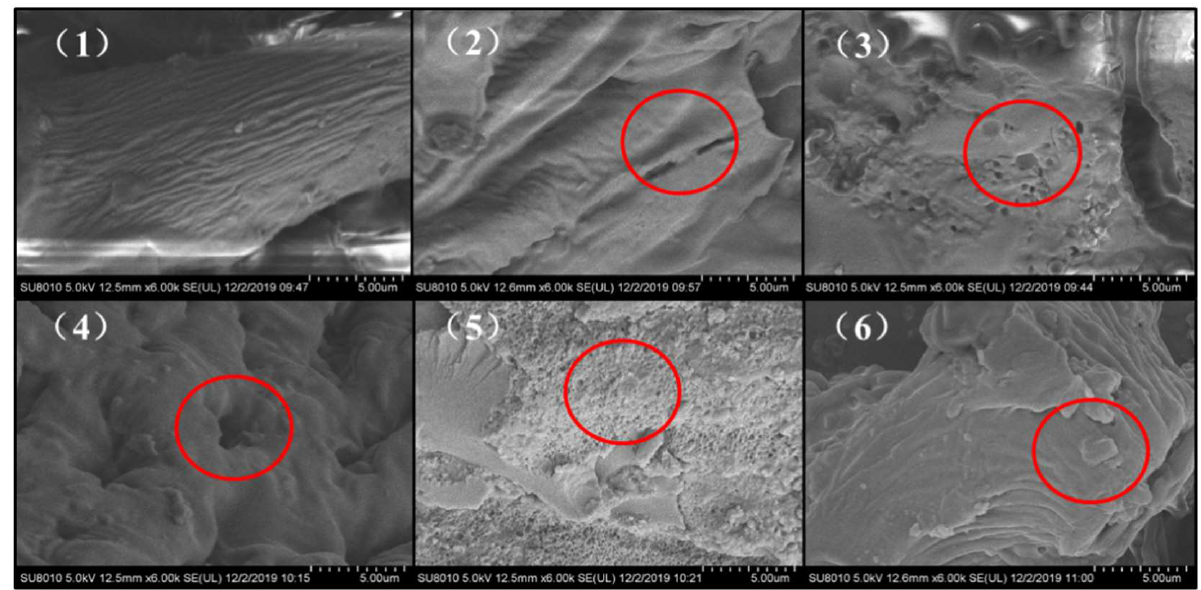
Figure 1. Scanning electron microscope (SEM) images of pea fiber after γ-irradiation. Note: ( 1 ) as the control, the irradiation doses of ( 2 )–( 6 ) were 0.5, 1, 2, 3, and 5 kGy, respectively, and the magnification was 6000×. Note: The red circles represent cracks, pores, and layered structures present in the γ -irradiation treatment samples.